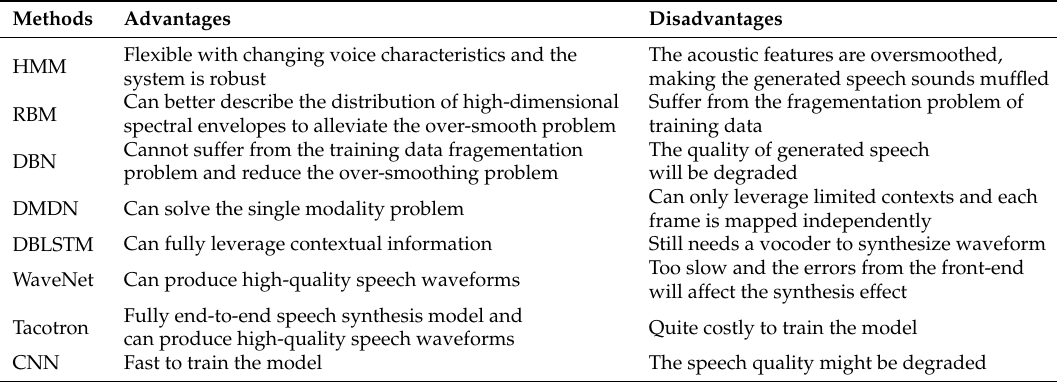
Table 1. The advantages and disadvantages of different speech synthesis methods, including hidden Markov model (HMM), restrictive Boltzmann machine (RBM), deep belief network (DBN), deep mixture density network (DMDN), deep bidirectional long short-term memory (DBLSTM), WaveNet, Tacotron and convolutional neural network